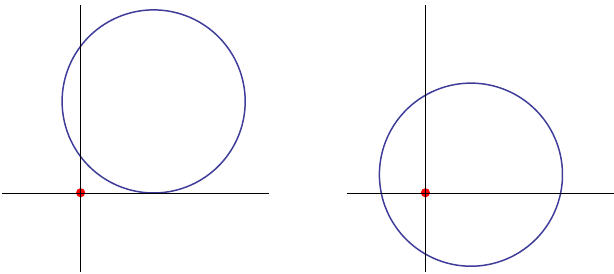
Figure 1. The two types of instanton con(cid:12)gurations. Left: the conical singularity lies outside the instanton con(cid:12)guration; the instanton lies on a single sheet of the replica spacetime. Right: here the conical singularity lies inside the instanton wall. The branch cut passes through the instanton wall and the instanton extends over all n sheets of the replica